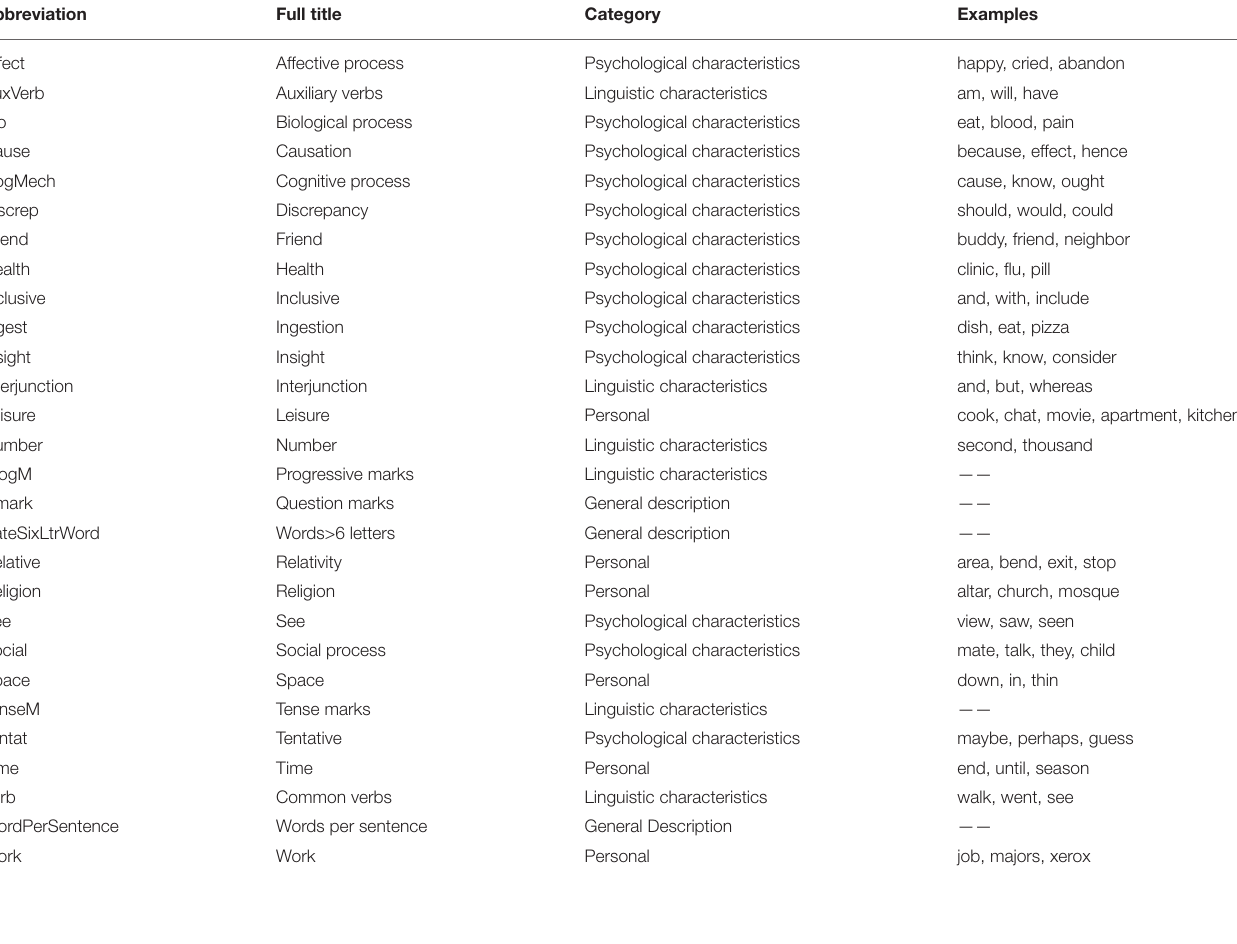
Table A1 | Full name, category and word examples of the identified